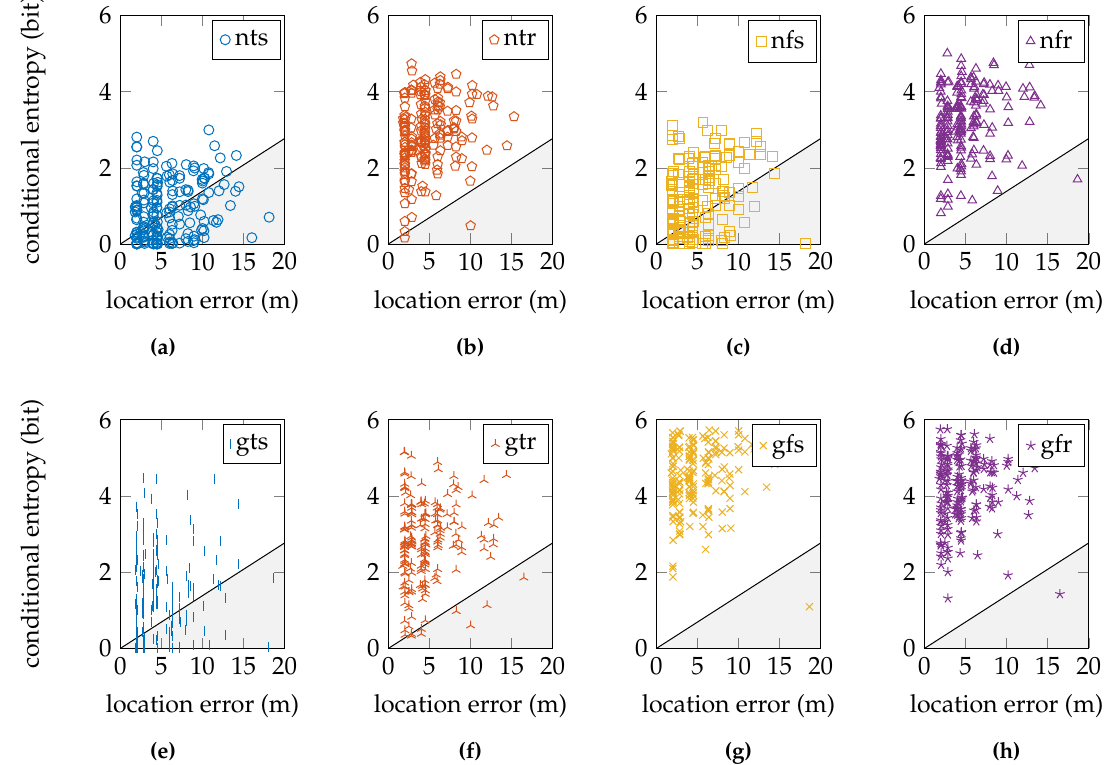
Figure 10. The relation tested on the EVARILOS dataset. The legend labels refer to using the normal sensor model (n) or using the convolution sensor model (g), using the trained σ (t) or using the fixed σ (f) and using a single reference location for training (s) or using a region of reference locations for training